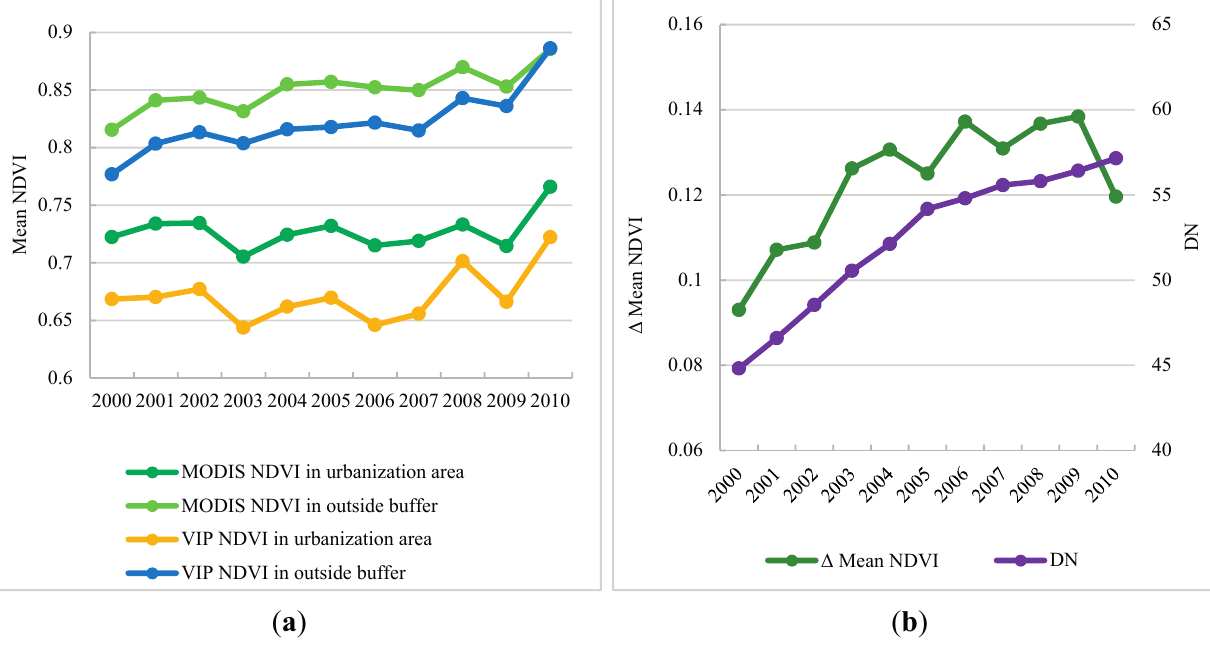
Figure 10. The vegetation change trends in different statistical objects or data sets for a case in Beijing. ( a ) Difference between the mean NDVI from two data sets of MODIS and VIP and ( b ) variation of Δ NDVI (mean NDVI in urbanization area minus mean NDVI in outside buffer) and DN in urbanization